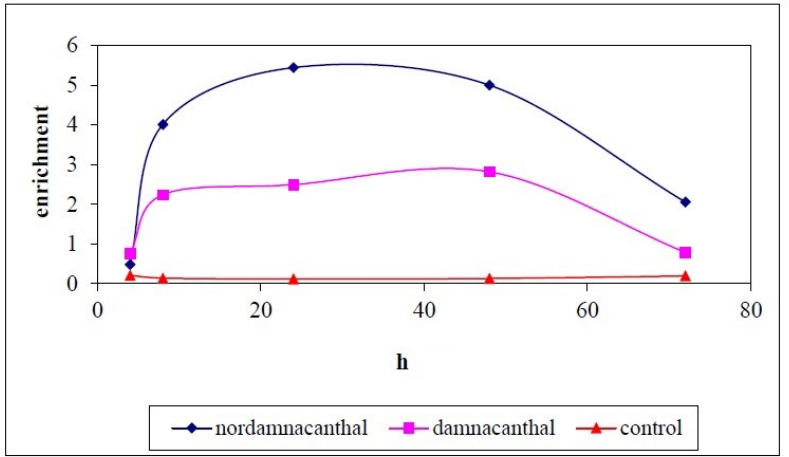
Figure 15. Enrichment of nucleosomes in cytoplasmic fractions of cell lysates at different hours of experiments. CEM-SS cells were treated with 30 μg/mL of indicated compounds. Control cultures were not treated with nordamnacanthal or damnacanthal. 20 μL of cell lysates were analyzed in the ELISA.